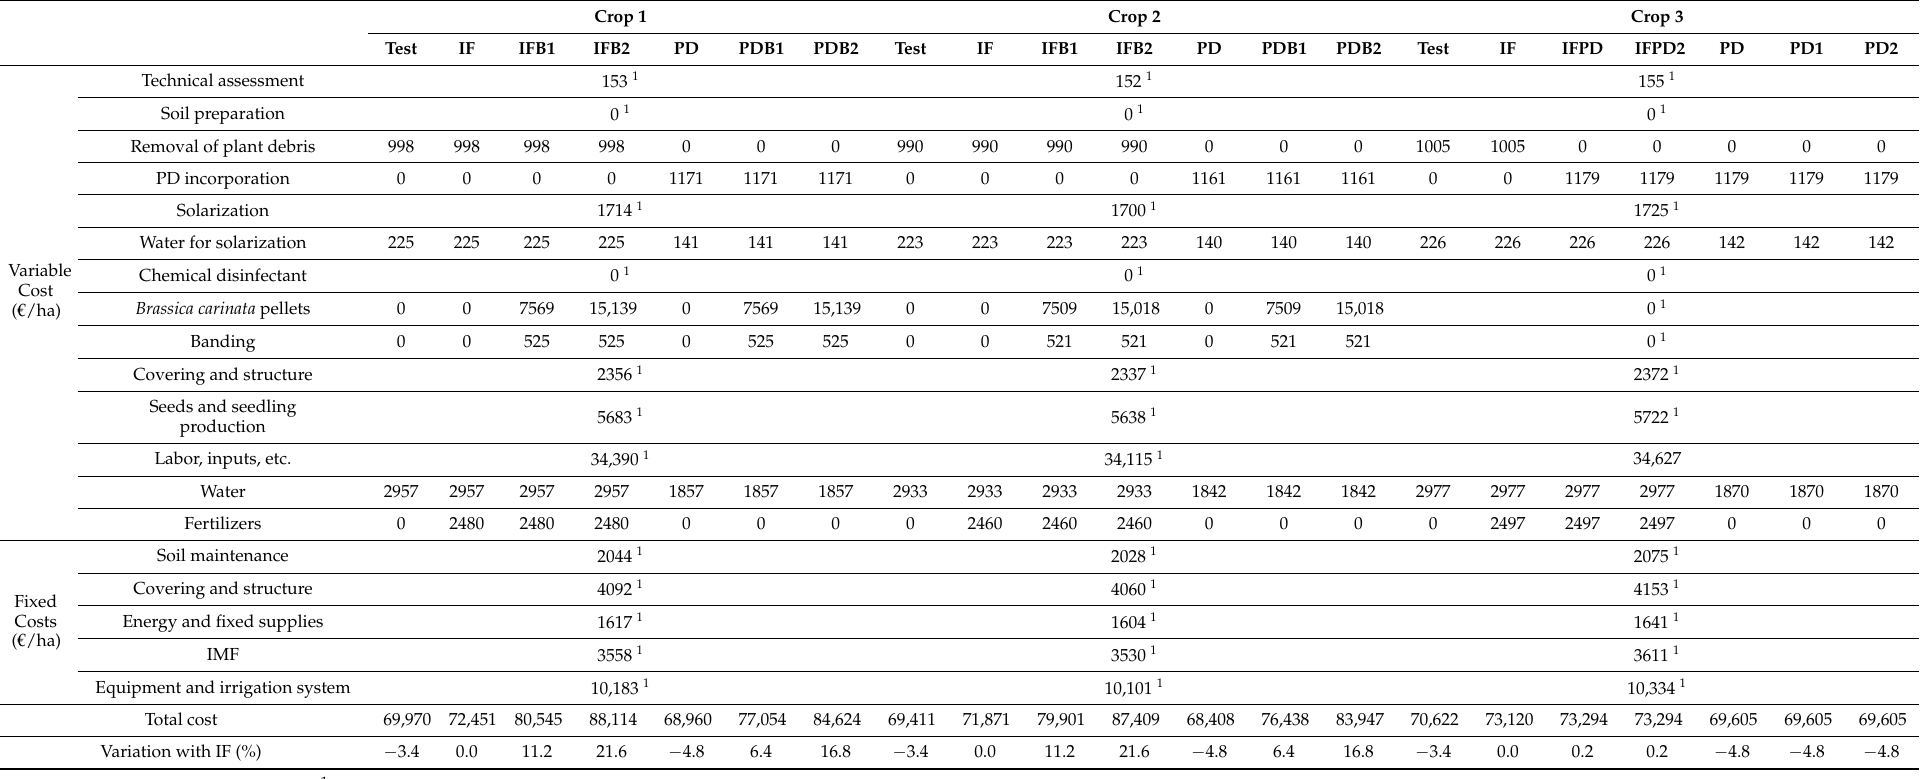
Table A1. Cost structure per hectare of the treatments used during the research in the three tomato crop